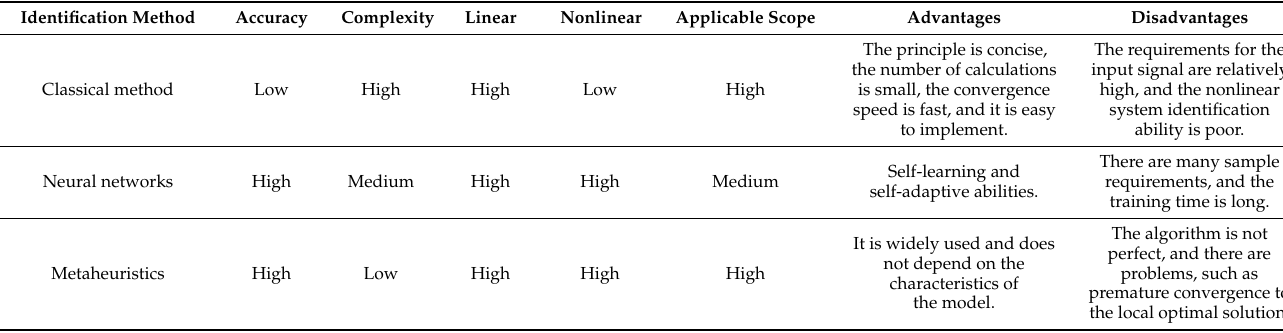
Table 3. Performance comparison of each identification